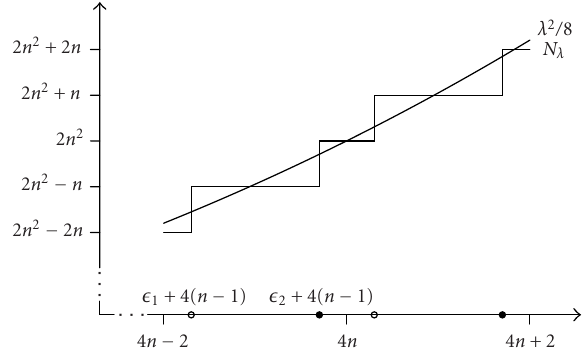
Figure 2.2. Plots of λ 2 / 8 and N λ on the interval [4 n − 2,4 n